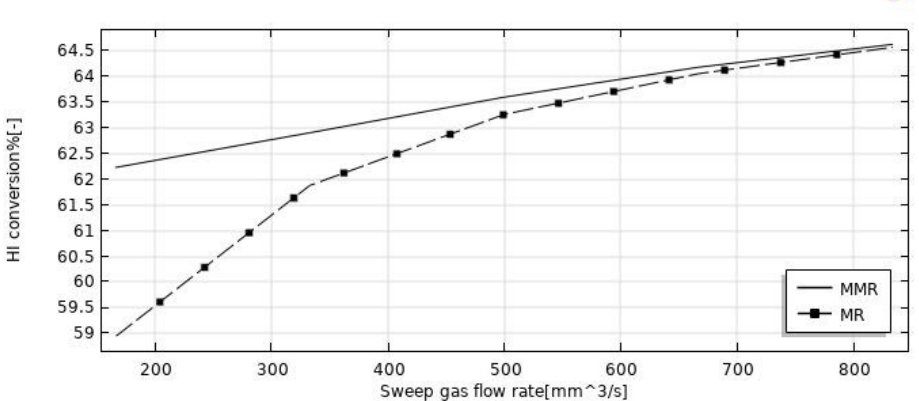
Figure 9. Effect of feed flow rate on the HI conversion at p = 1 bar, T = 400 °C, and feed flow rate = 20 mm 3 /s.